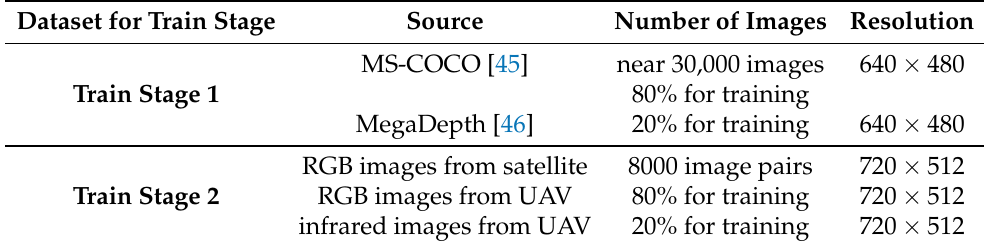
Figure 9. The proposed training pipeline. Table 2. The detail of the training and validation